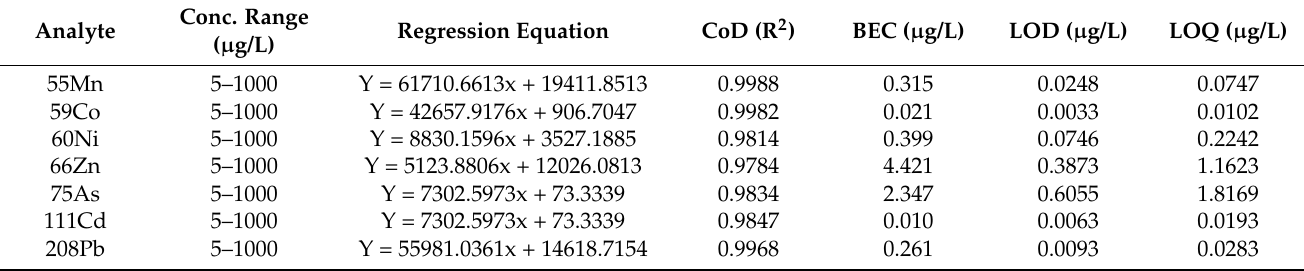
Table 3. Results of regression equations, CoD, BEC, LOD and LOQ obtained by iCAP Q ICP-MS. Conc. Analyte